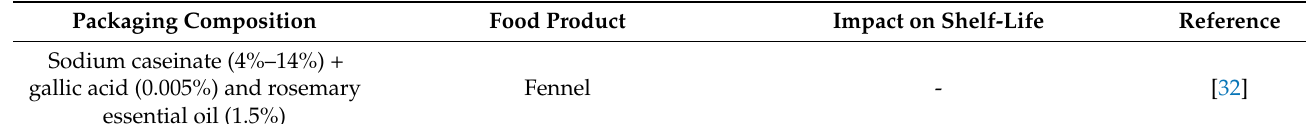
Table 2. Application of different casein-based packaging